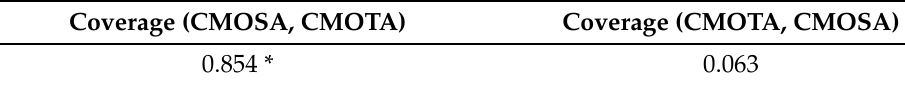
Table 5. Results obtained by the coverage